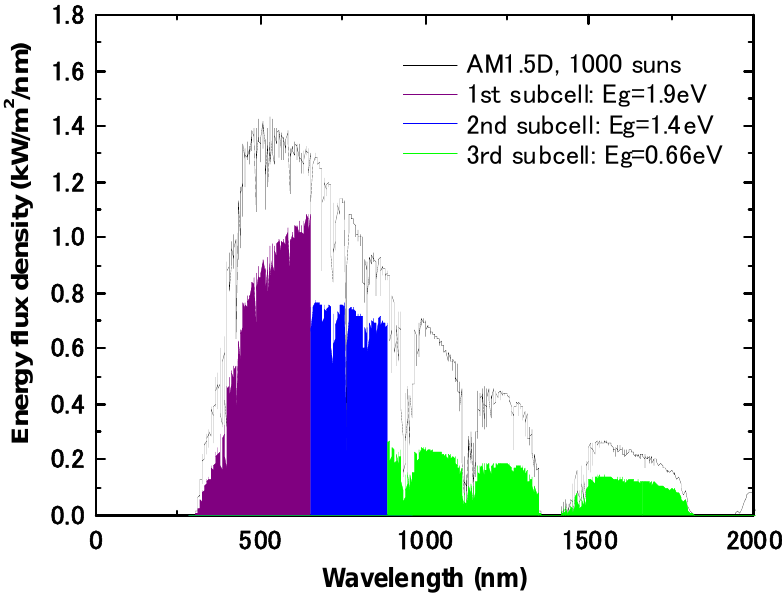
Figure 3. Solar irradiation spectrum of AM1.5D, 1,000 suns and energy utilization spectrum by a series-connected AlInGaP (1.9 eV) / GaAs (1.4 eV) / Ge (0.66 eV) triple- junction solar cell calculated with the “detailed balance limit” scheme with current-match restriction. Calculated energy conversion efficiency η = 50.1% ( η = 41.4% under AM1.5G, 1